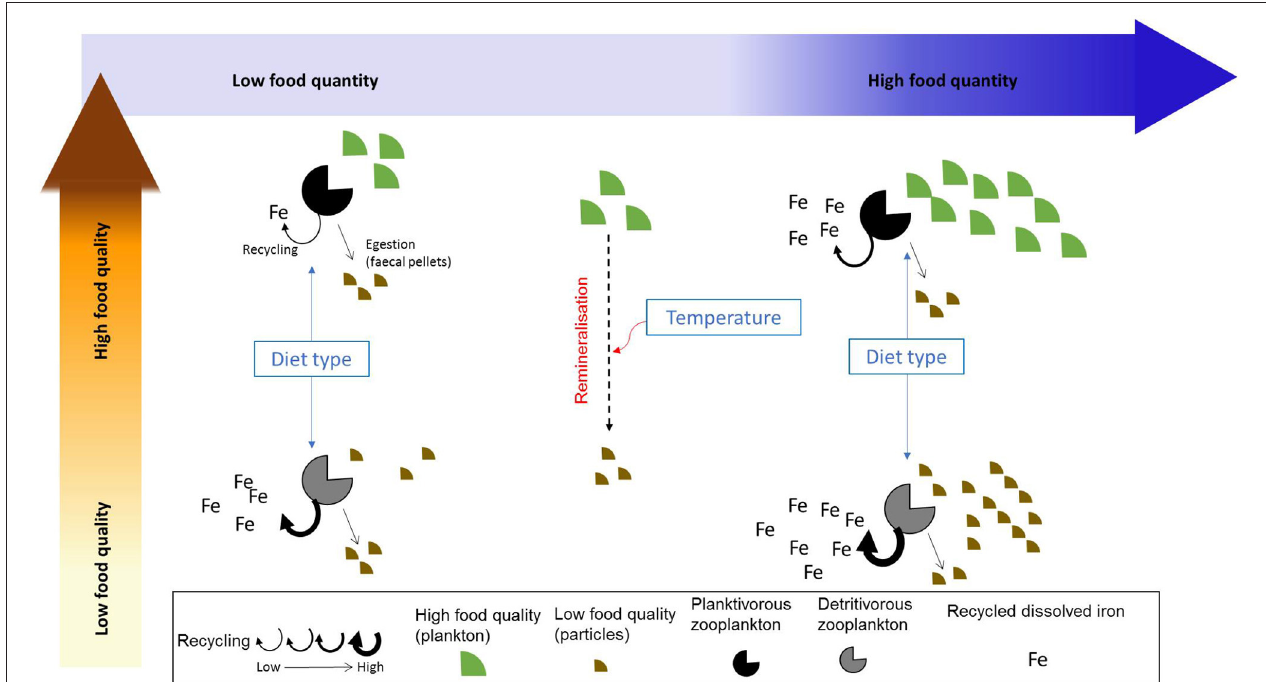
FIGURE 1 | Summarized view of the factors influencing iron recycling by zooplankton. We emphasize the effects of food quality and quantity on iron recycling as well as the indirect influence of zooplankton diet type and temperature.